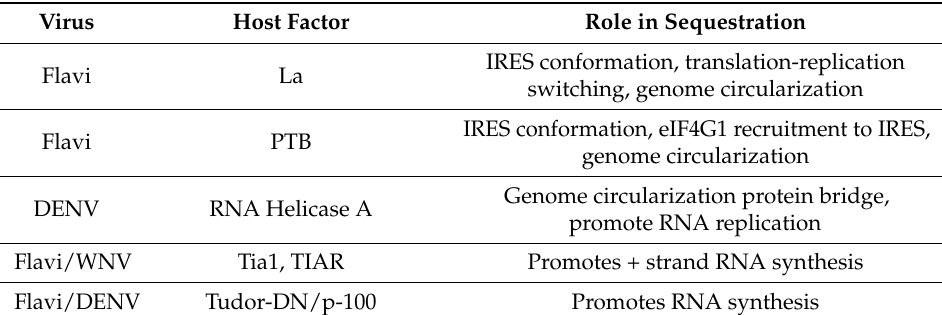
Table 1. Sequestered host nuclear factors (adapted from